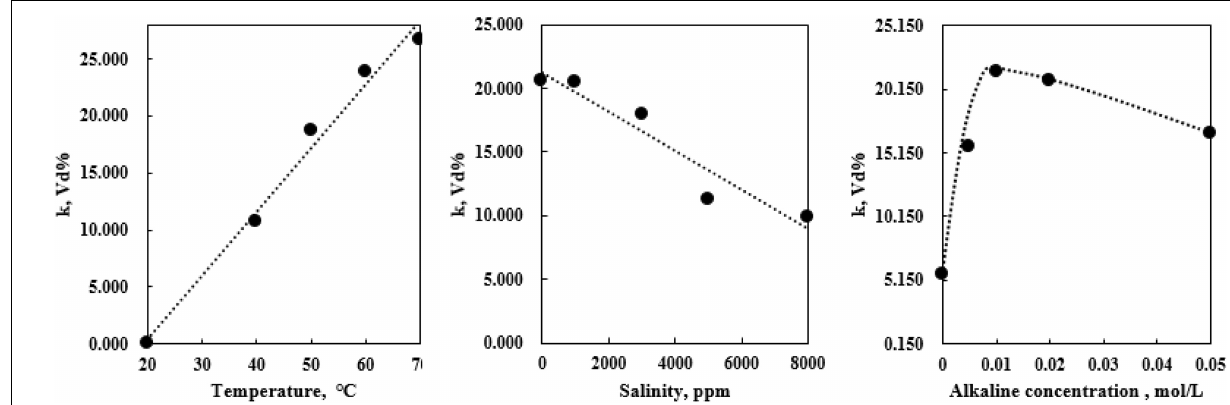
FIGURE 4 | k n trend of changing control factors of NaOH orthogonal bottle test.